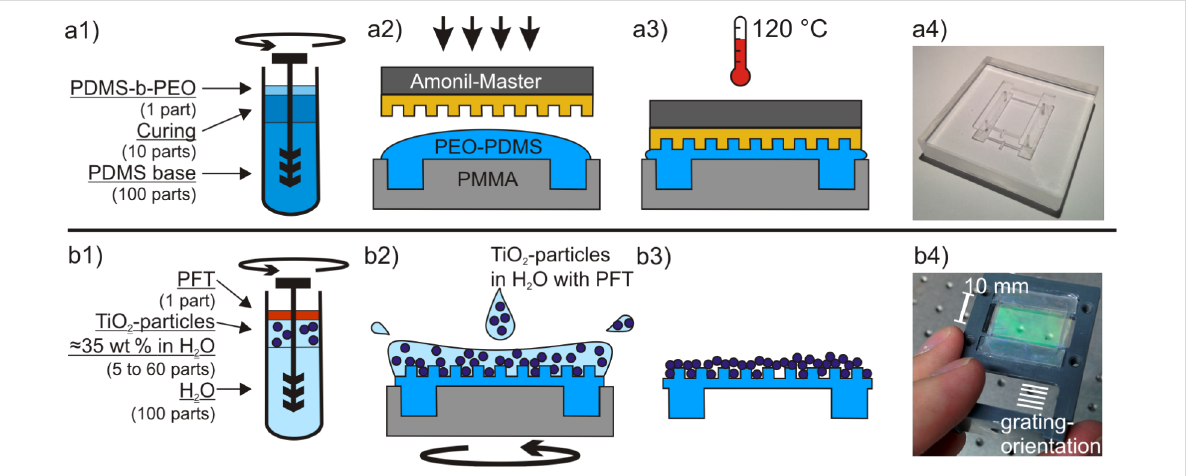
Figure 6: Fabrication of the flexible photonic crystal membrane by molding and imprinting a PDMS membrane with a nanostructure (a1–a3) and applying a high index layer by spin coating of high index nanoparticles (b1–b3). a4) shows the mold for the PDMS substrate and b4) shows a complet- ed photonic crystal membrane on which the grating reflections are visible.